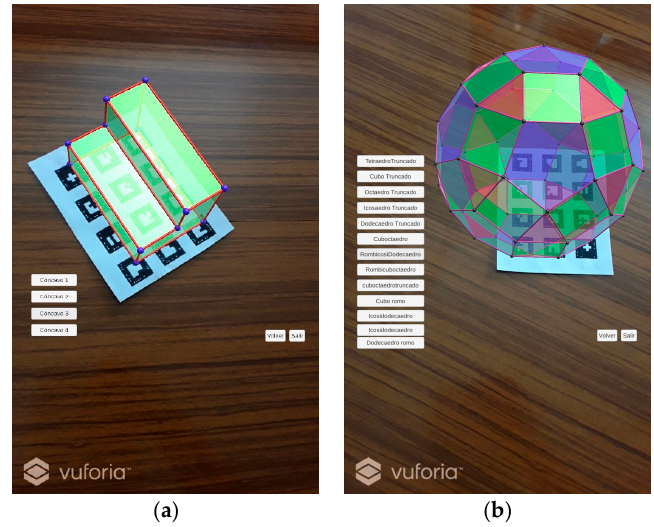
Figure 3. Examples of concave and convex polyhedra with augmented reality (AR). ( a ) Concave polyhedron; ( b ) Convex polyhedron. polyhedron; ( b ) Convex Class session 3